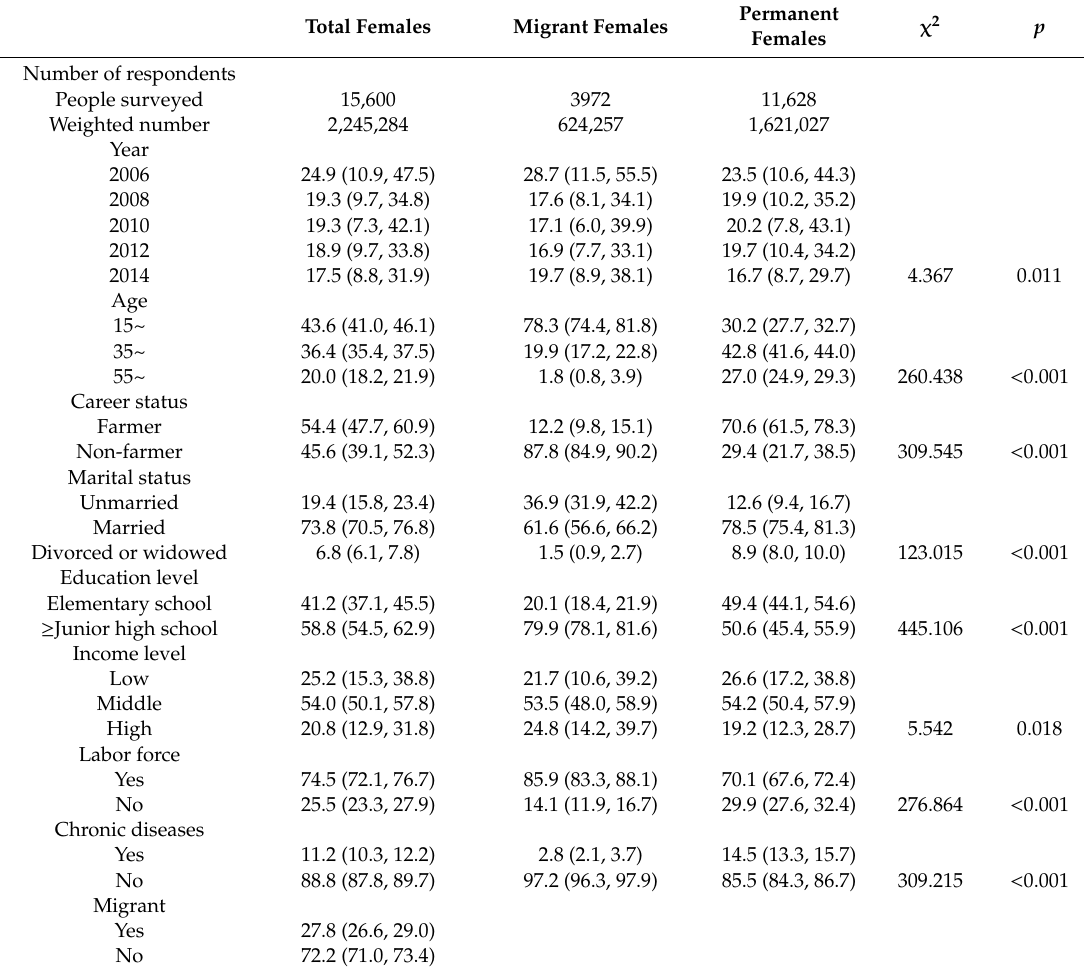
Table 2. Distribution of demographic characteristics in three counties among total amount of females, migrant females, and permanent females. (%, 95% CI) *. Total Females Migrant Females